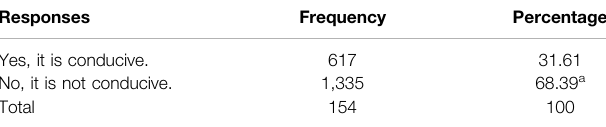
TABLE 8 | Faculty, staff and students ’ access to internet/Wi- fi .